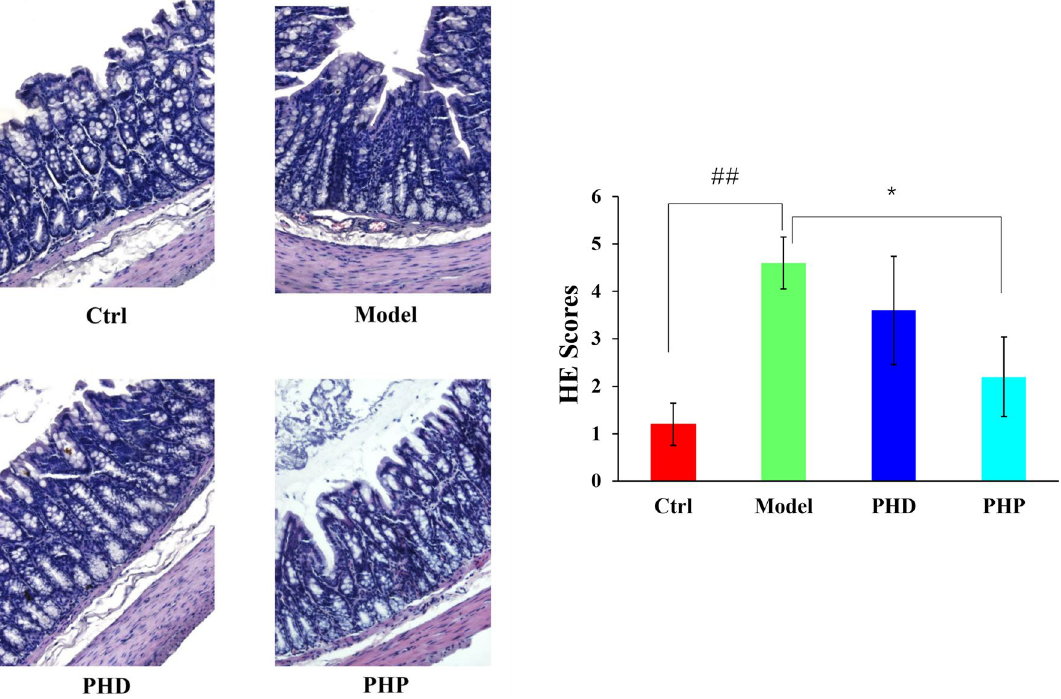
Figure 3. Representative images of the HE-stained sections (200 × magnification) from the colons in four groups. Values was presented as mean ± SD (n = 5). Significant differences ( p < 0.05 ) were determined by one-way ANOVA and independent samples Kruskal–Wallis test using SPSS (version 33.0) software.